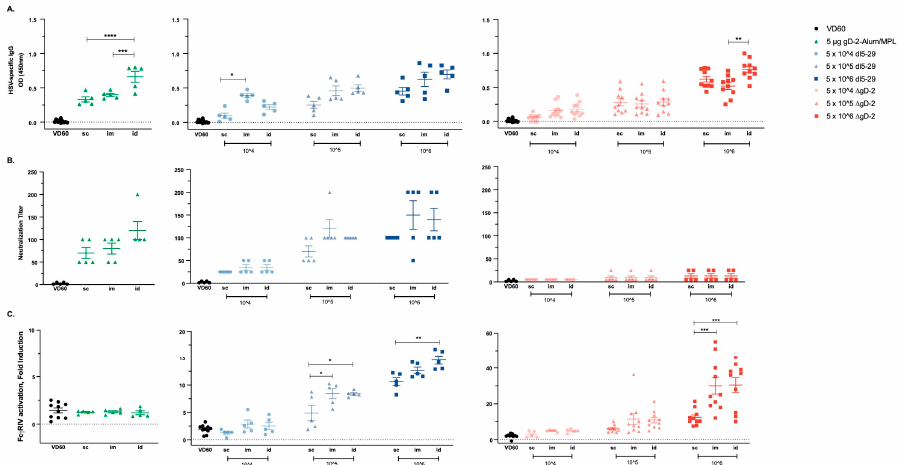
Figure1. Figure 1. Immunogenicity of viral and adjuvanted subunit herpes simplex virus (HSV) vaccines is